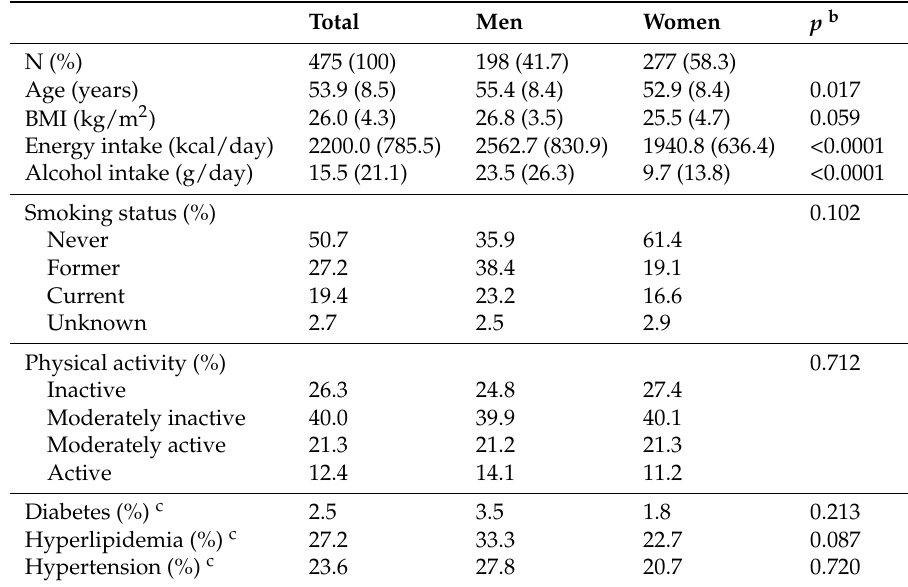
Table 1. General characteristics a of the total study population ( n =